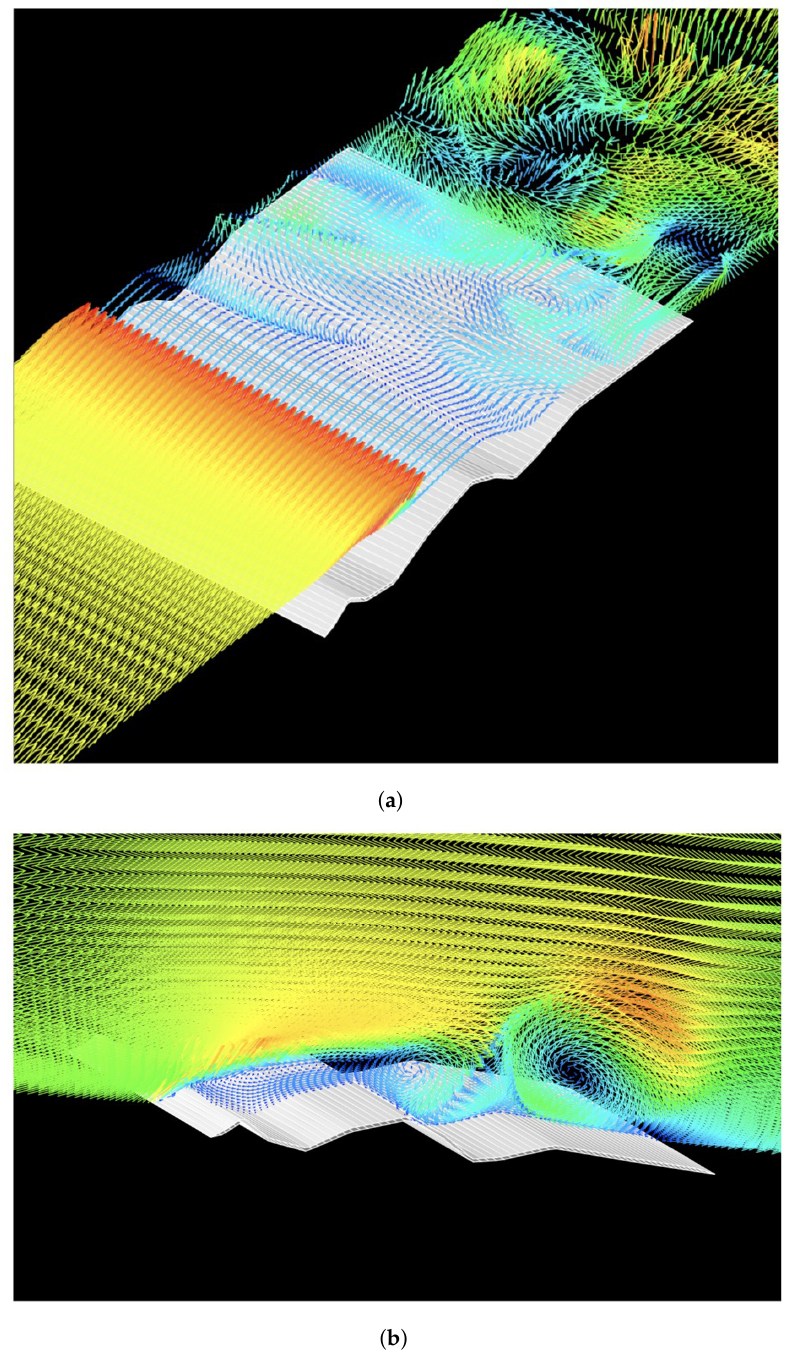
Figure 15. Instantaneous velocity field on the upper surface of the corrugated airfoil at angle of attack of 8 ◦ , Re = 4000: ( a ) top view; and ( b ) front